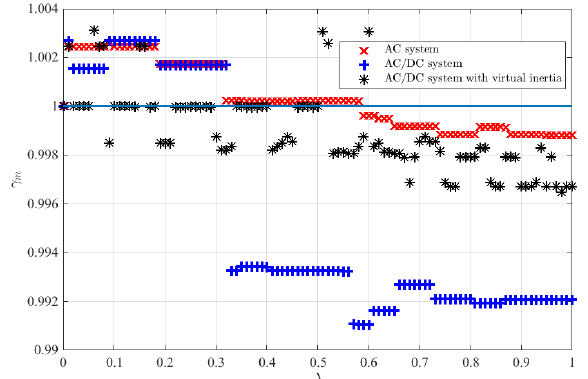
Φ ( 1 − λ ) for the three load frequency 2 1